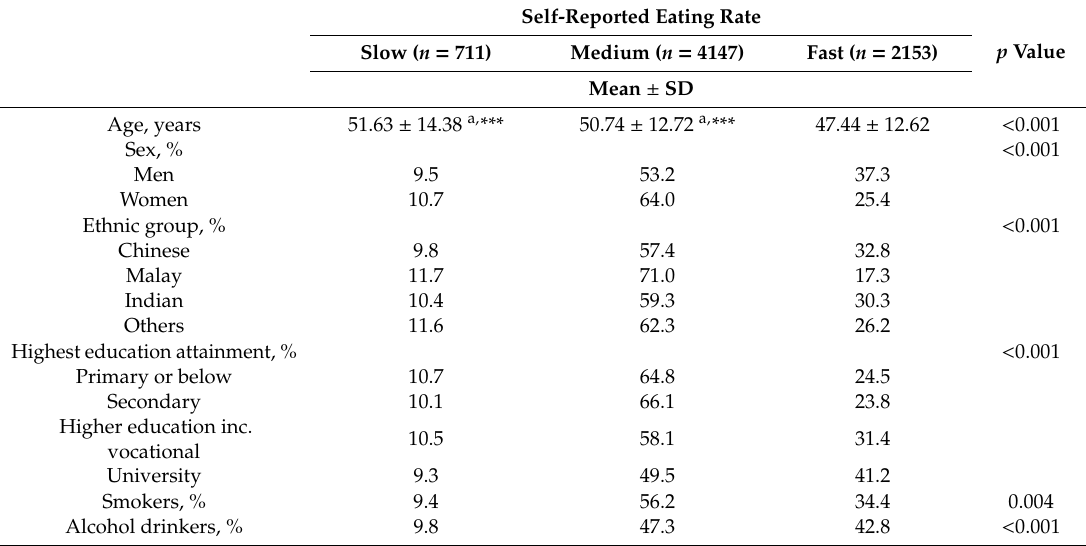
Table 1. General characteristics of participants according to tertile groups of self-reported eating rate in the Singapore Multi-Ethnic Cohort 2, n =